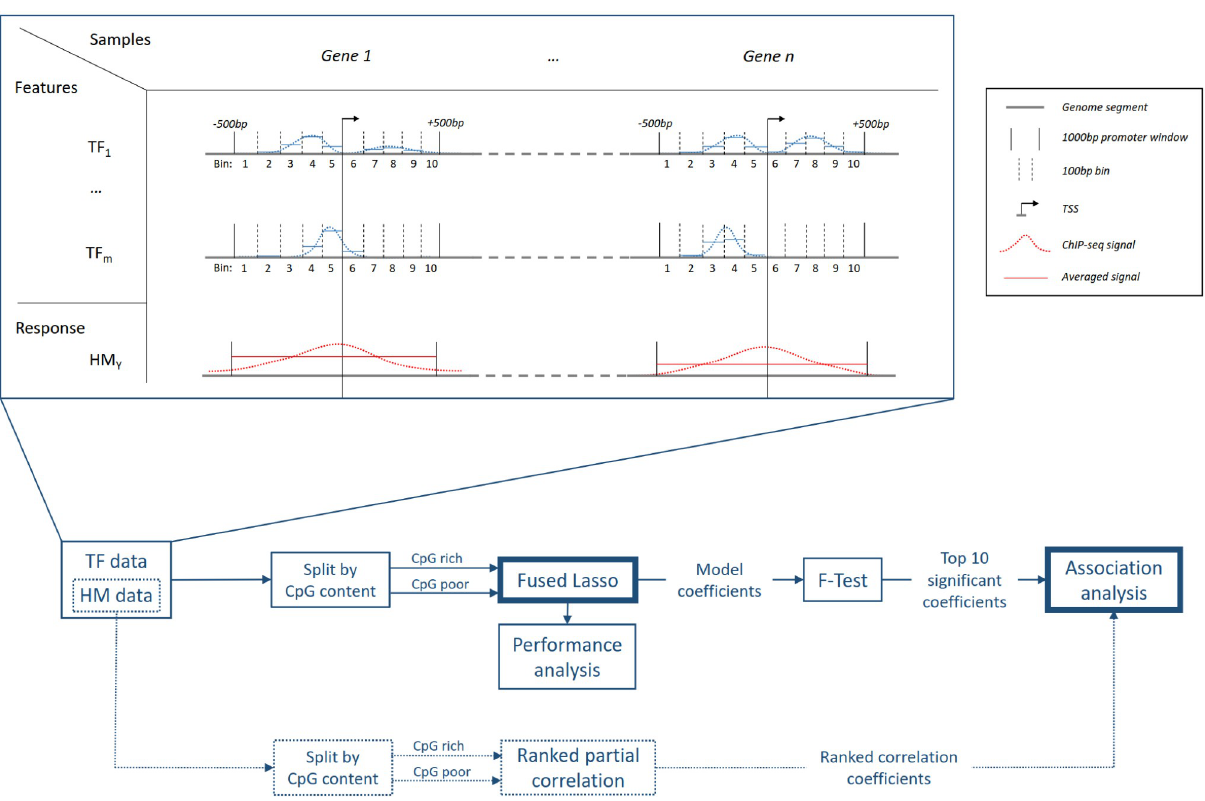
Fig 1. Workflow of this association study. Top : Summary of the data processing pipeline. Promoter regions of protein coding genes are taken as samples (columns). Each HM ChIP-seq signal (dotted red lines) in a window (black vertical lines) from 500bp upstream to 500bp downstream of the TSS is averaged to obtain the response values for our models (solid red lines). For the TF data, we further segment this window into ten non-overlapping bins (black vertical dashed lines), each of which is of length 100bp. The TF ChIP-seq signal (blue dotted lines) is averaged (solid blue lines) inside each bin to obtain a higher resolution for the features. Bottom : Sketch of the steps involved in this association study. Starting from the data set, described at the top, the samples (gene sets) are split by CpG content and separate models for each set are trained. The derived coefficients are then processed to test for statistical significance with an F-Test and the top 10 significant coefficients are used for the association analysis. To further support the analysis, we examine the ranked partial correlation coefficients of the Histone Modification data.